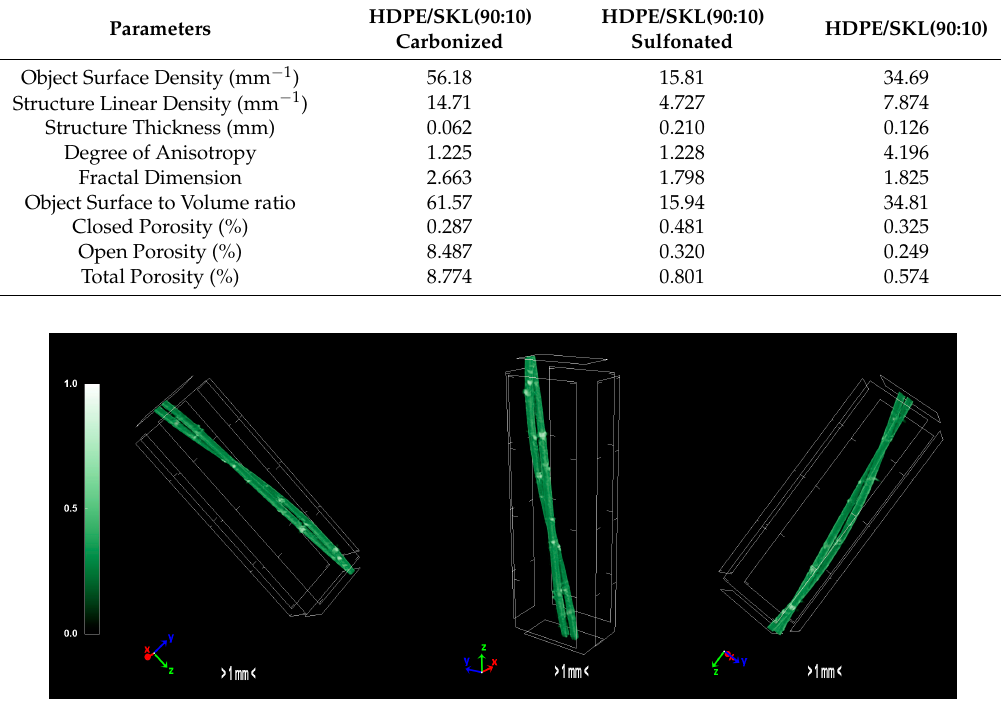
Figure 8. Micro-CT images of the HDPE fibers.